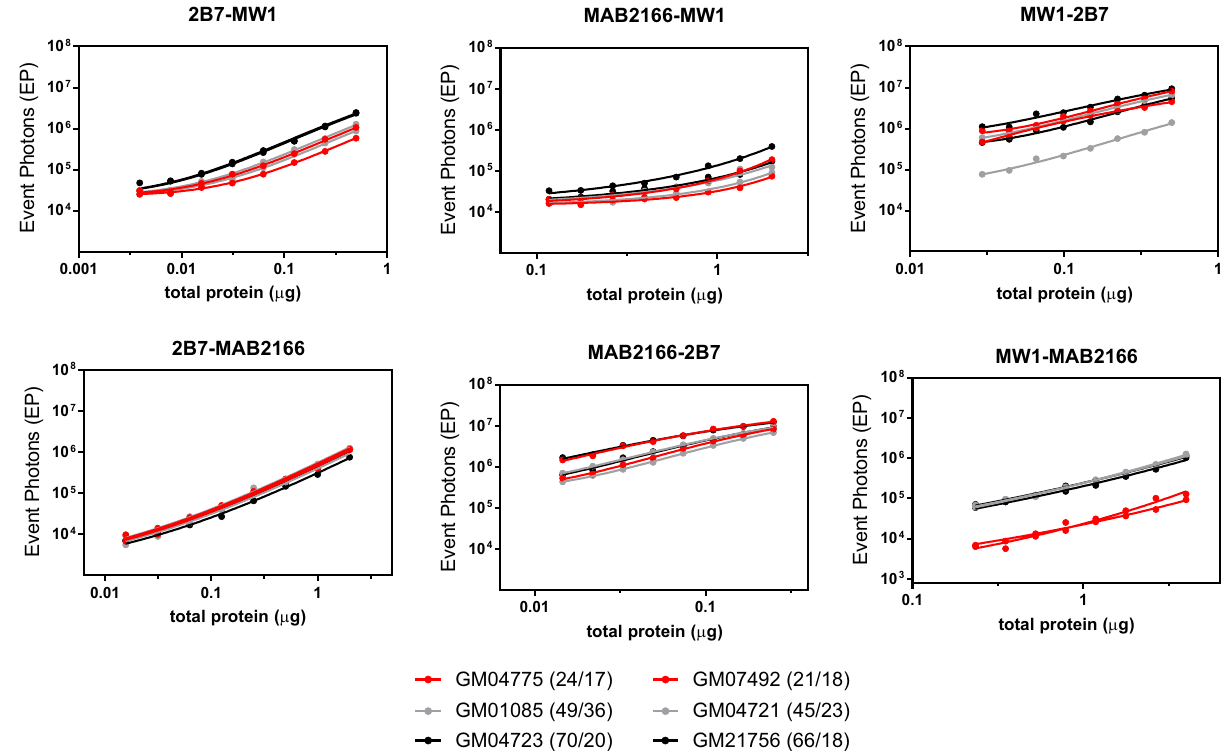
Figure 5. mHTT specificity of the detection in normal, HD, and JHD human fibroblast lysates. Two control GM04775 (24/17) and GM07492 (21/18), two HD GM04721 (49/36) and GM01085 (45/23) and two JHD GM04723 (70/20) and GM21756 (66/18) fibroblast cell lysates were diluted and assayed via SMC using the antibody pair reported on the title of each chart. Due to the large difference in sensitivity among the various antibody pair, the x-axis scale is not directly comparable for all charts. Each experimental point is reported as the average and standard deviations of a triplicate. Results for assays containing the HDB4E10 and 4C9 antibodies are reported in Fig.